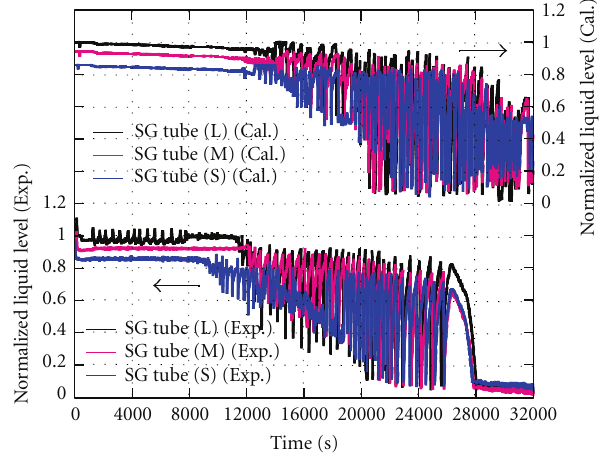
Figure 14: LSTF and RELAP5 results for collapsed liquid levels in upflow side of SG U-tubes in loop with PZR.